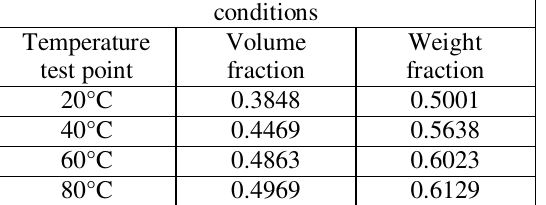
Table 2: Fiber fractions at given processing